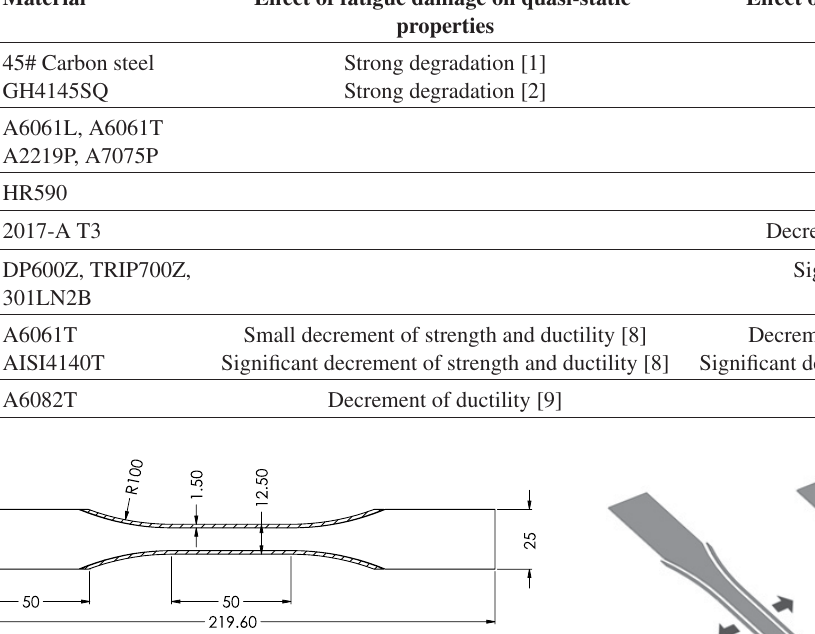
Fig. 1. Specimen geometry for fatigue loading and quasi-static tensile testing. The edges (shaded in the figure) are removed after cyclic loading to avoid the e ff ect of fatigue cracks on tensile tests. See also figure 3.